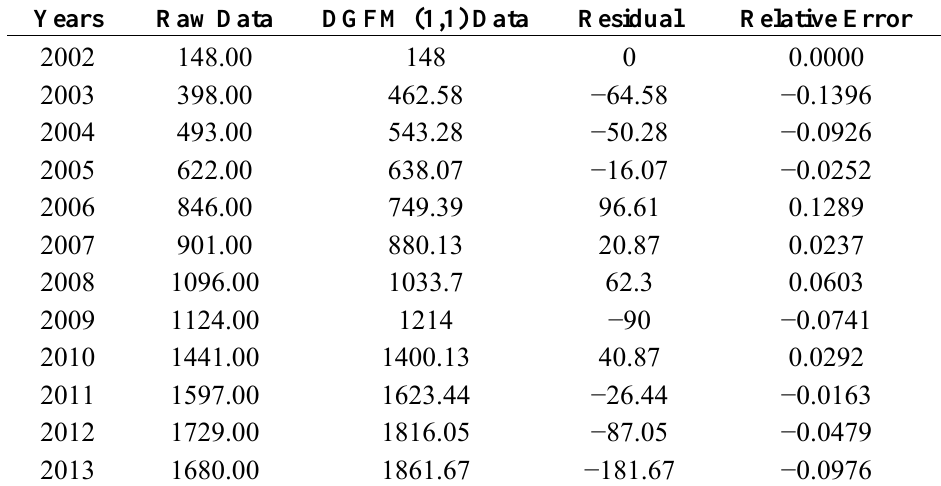
Table 8. Forecast data using the dynamic grey fuzzy Markov DGFM (1,1) model (2002 to 2013).